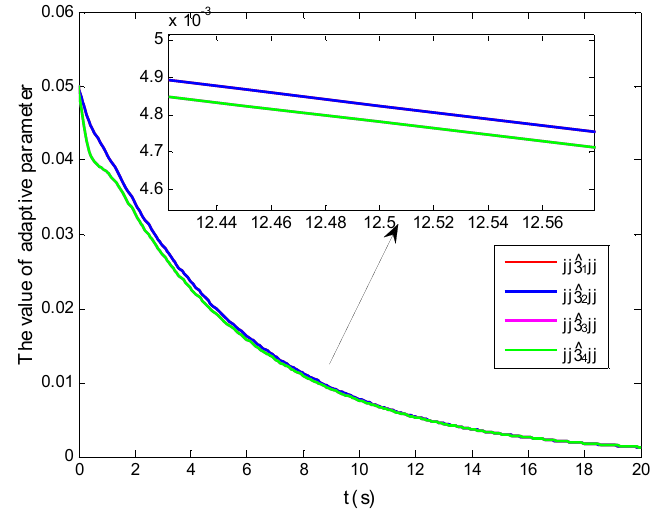
ˆ ( Figure 8. The trajectories of adaptive parameters ˆ θ i ( i = 1,2,3,4 )